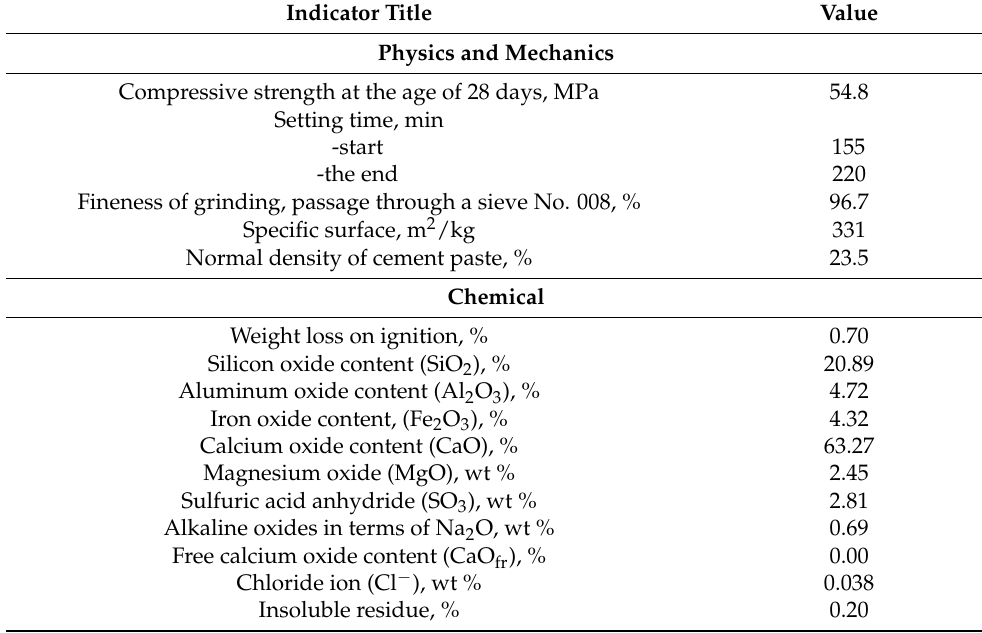
Table 1. Physical and mechanical characteristics of Portland cement PC 500 D0 and its chemical